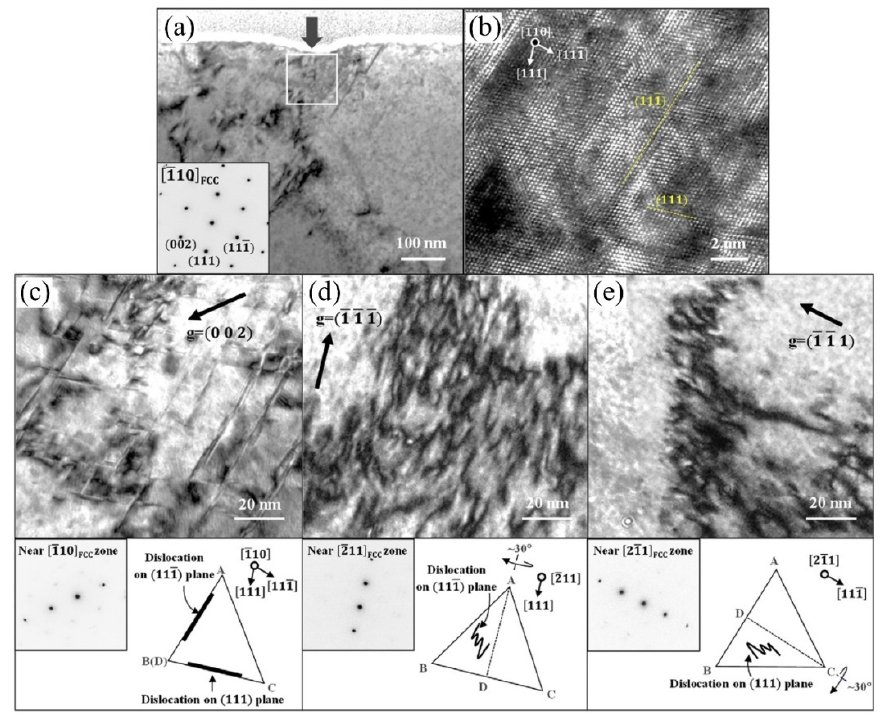
Figure 3. ( a ) TEM bright-field image depicting the defect structure in the austenite grain beneath the indenter. The lower left inset is the selected area diffraction pattern. ( b ) High-resolution TEM (HRTEM) image displaying the presence of dislocations along the different slip planes. ( c – e ) Magnified view of the rectangle in ( a ), showing the dislocations under different two-beam conditions. The schematic illustration as shown in ( c – e ) are the tetrahedron demonstrating the orientation of {111} slip plane, and the perfect dislocations on different slip planes [81]. Reprinted with permission from ref. [81]. Copyright 2017, Elsevier.